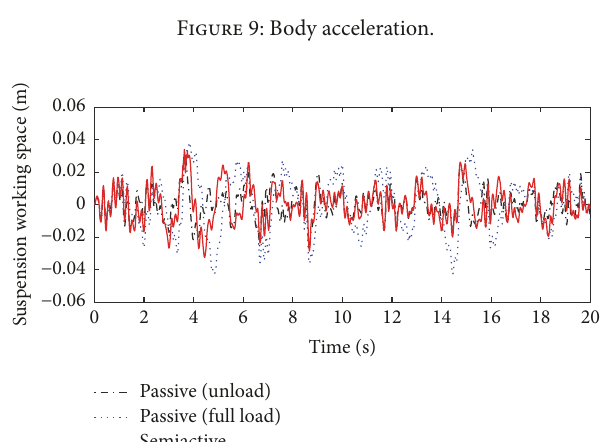
Figure 10: Suspension working space.